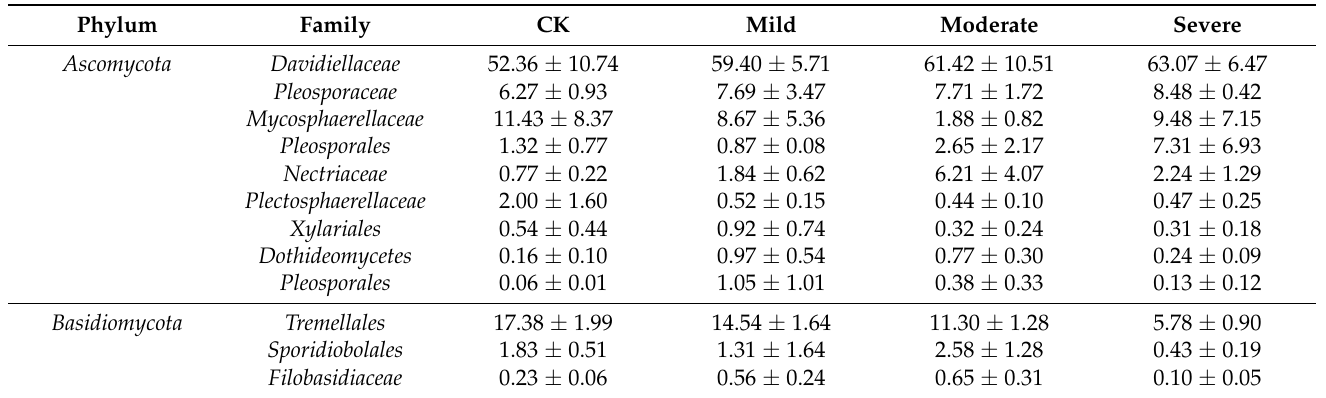
Table 3. The relative abundances (%) of the families of different fungi under salt stress. Phylum Family CK Mild Moderate Severe